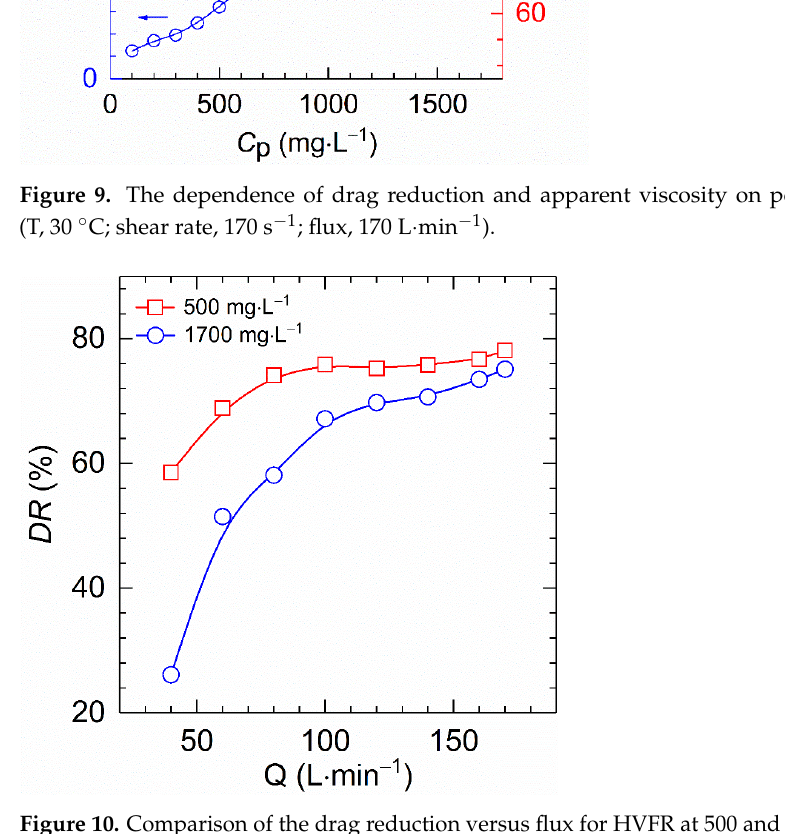
Figure 10. Comparison of the drag reduction versus flux for HVFR at 500 and 1700 mg ⋅ L − 1 at 30 °C.